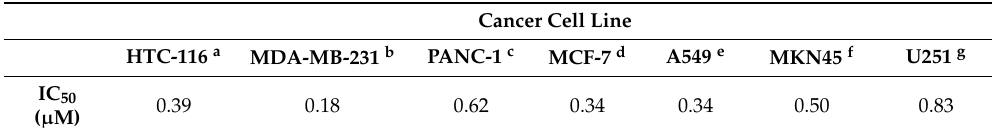
Table 3. Anticancer activity of 76 in human cancer cell lines.